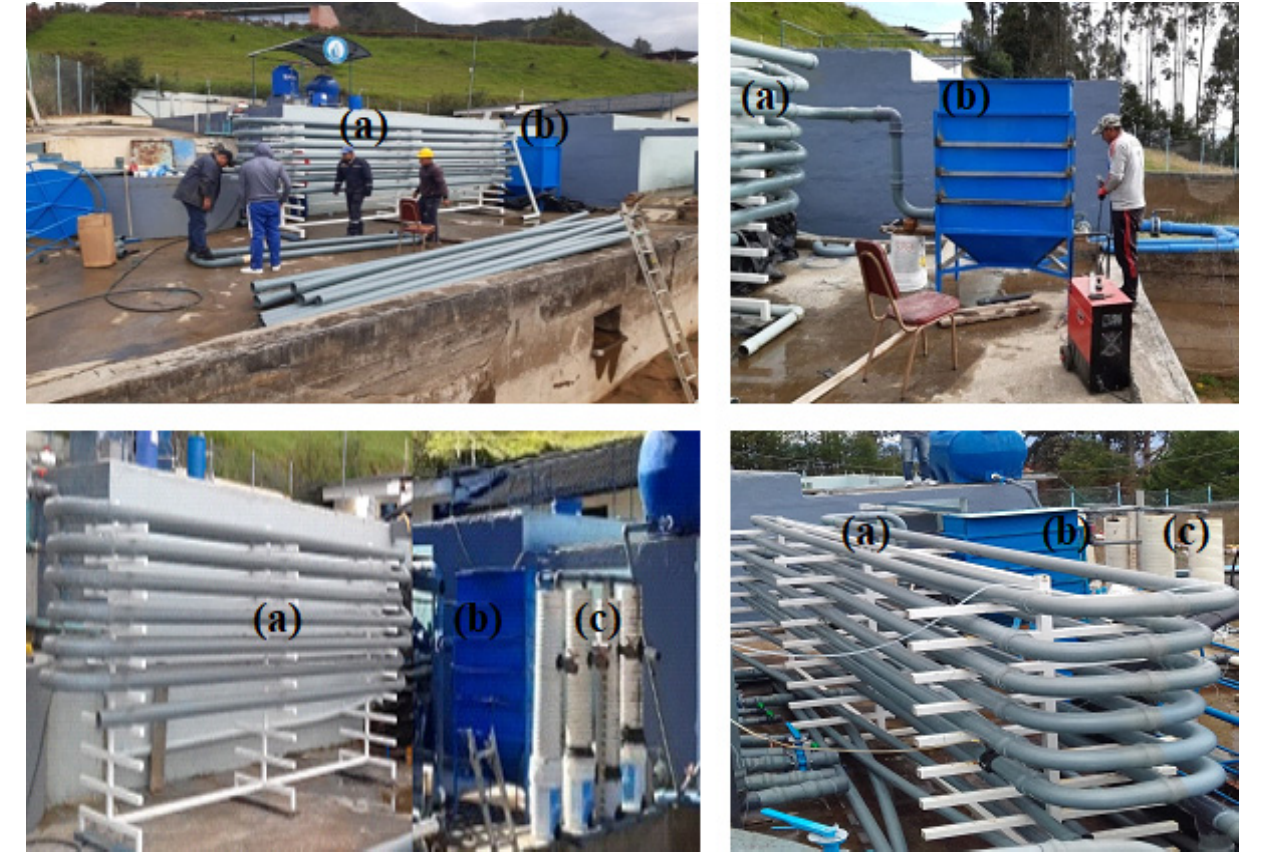
Figure 13. Implementation of the Pilot Treatment System. The upper left figure shows the HTF implementation; in the upper right, the implementation of the settler is presented. The complete experimental system is presented in the lower left and right figures, as follows: (a) HTF, (b) high-rate settler, and (c) rapid sand